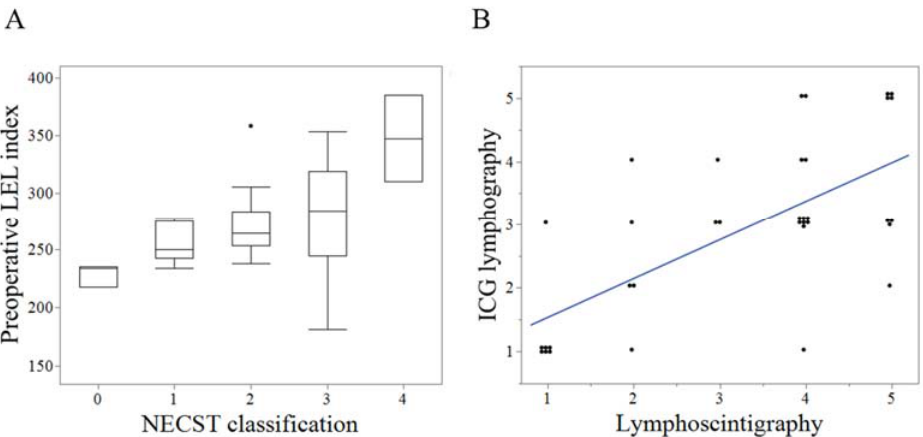
Figure 4. Reproducibility of the clinical severity staging and image staging. ( A ). Box plot of the correlation between preoperative lower extremity lymphedema (LEL) index and indocyanine green (ICG) lymphography stage. ( B ). Scattered plot of the correlation between lymphoscintigraphy and ICG lymphography staging.